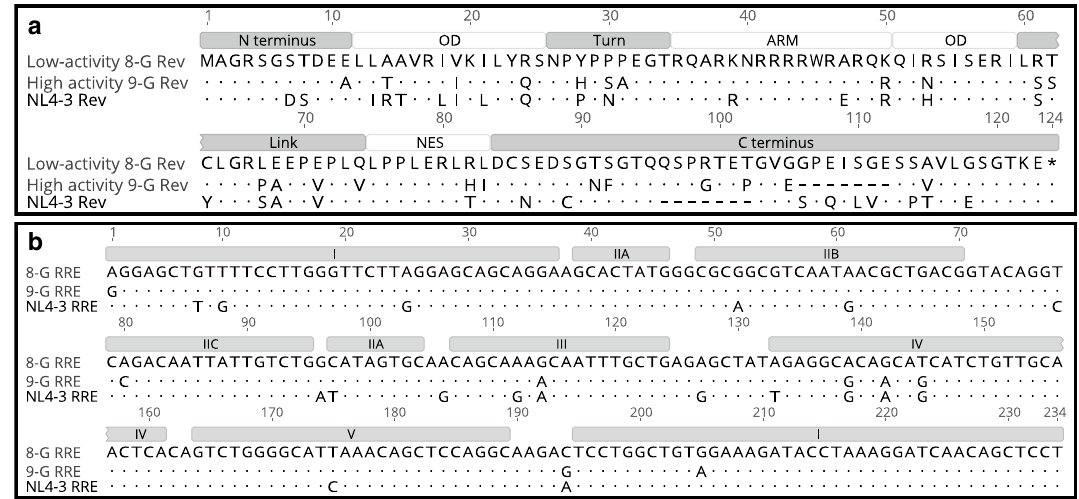
Figure 1. Alignment of Rev and RREs. ( a ) The amino acid sequences of the Revs corresponding to the 8-G, 9-G, and NL4-3 viruses were aligned. Differences relative to the 8-G sequence are highlighted. Dots represent identical amino acid residues to the 8-G sequence, while dashes represent a deletion relative to 8-G. Functional domains are marked above the alignment. ( b ) The nucleic acid sequences of the 234-nt RREs corresponding to the 8-G, 9-G, and NL4-3 viruses were aligned. Differences relative to the 8-G sequence are highlighted. Dots represent an identical base to 8-G. Regions that would fold to form a five stem-loop RNA structure are noted above the sequence. OD—oligomerization domain, ARM—arginine rich motif, NES—nuclear export